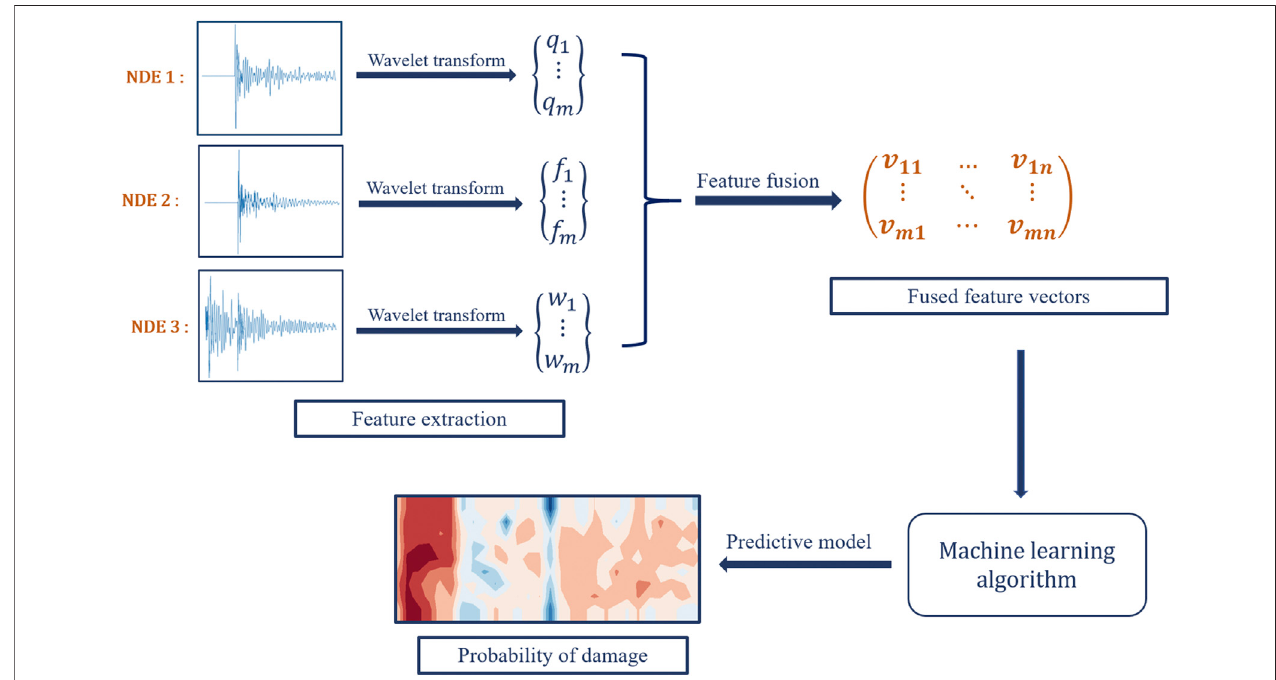
FIGURE 1 | Schematic overview of the proposed methodology for multiple NDE feature fusion.